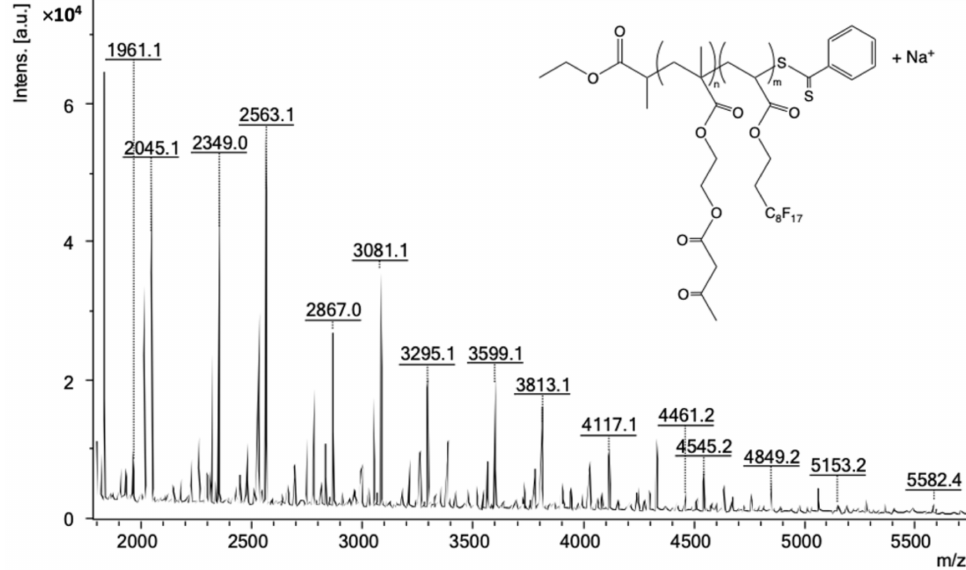
Figure 7. MALDI-TOF-MS mass spectrum in positive ion mode of P(AAEM- co -FDA) gradient